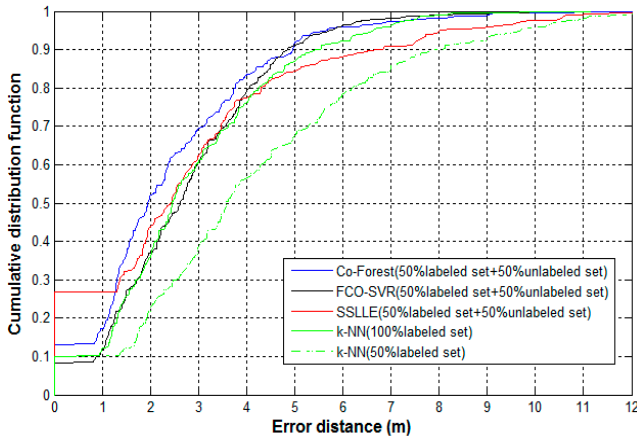
Figure 8. CDF plots of error distances for the four algorithms. Table 4. Comparison of the mean error, maximum error, minimum error, and median error for the four algorithms.